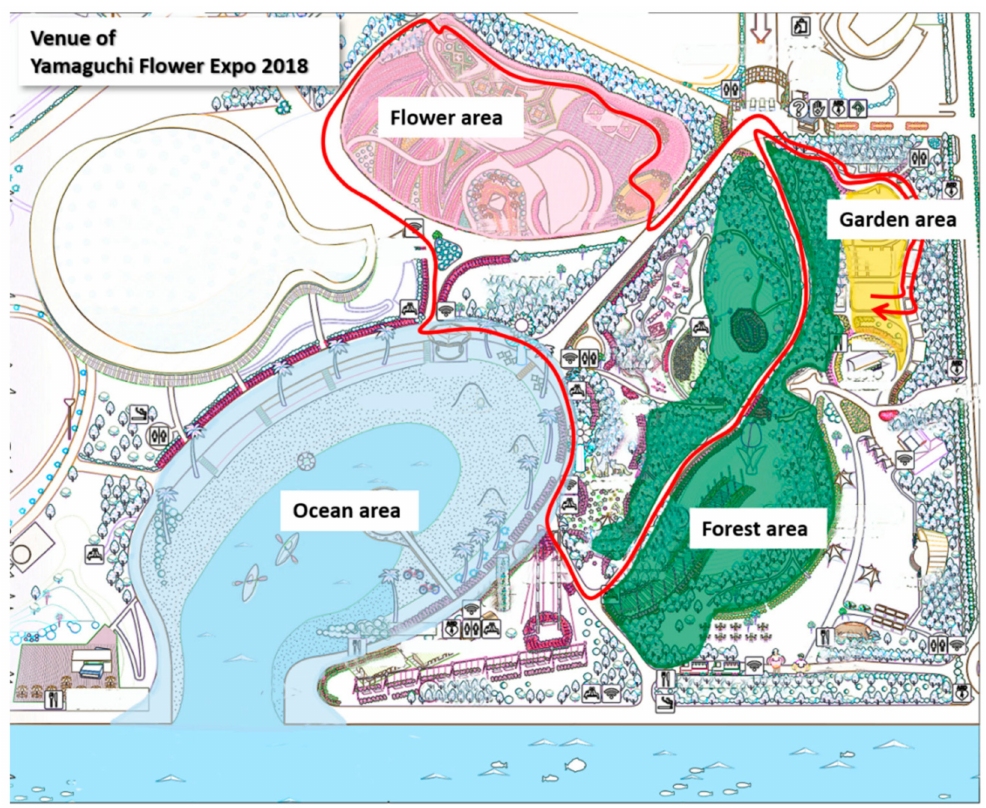
Figure 1. Study site: flower area (pink), ocean area (blue), forest area (green), and Garden for Health (yellow). The red trails indicate the main walking circuit.